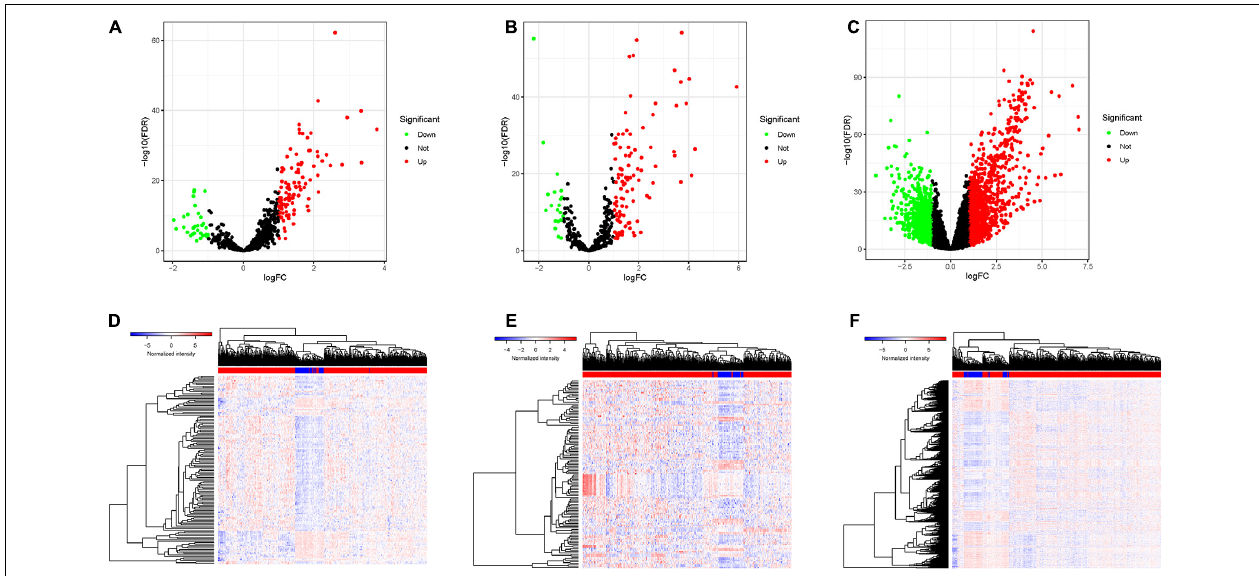
FIGURE 1 | The DEGs between HCC samples and normal liver tissues. (A) Volcano plots of the expression levels of DELs. (B) Heatmaps of the expression levels of DELs. Red represents upregulated expression, and green represents downregulated expression. (C) Volcano plots of the expression levels of DEMis. (D) Heatmaps of the expression levels of DEMis. (E) Volcano plots of the expression levels of DEMs. (F) Heatmaps of the expression levels of DEMs.